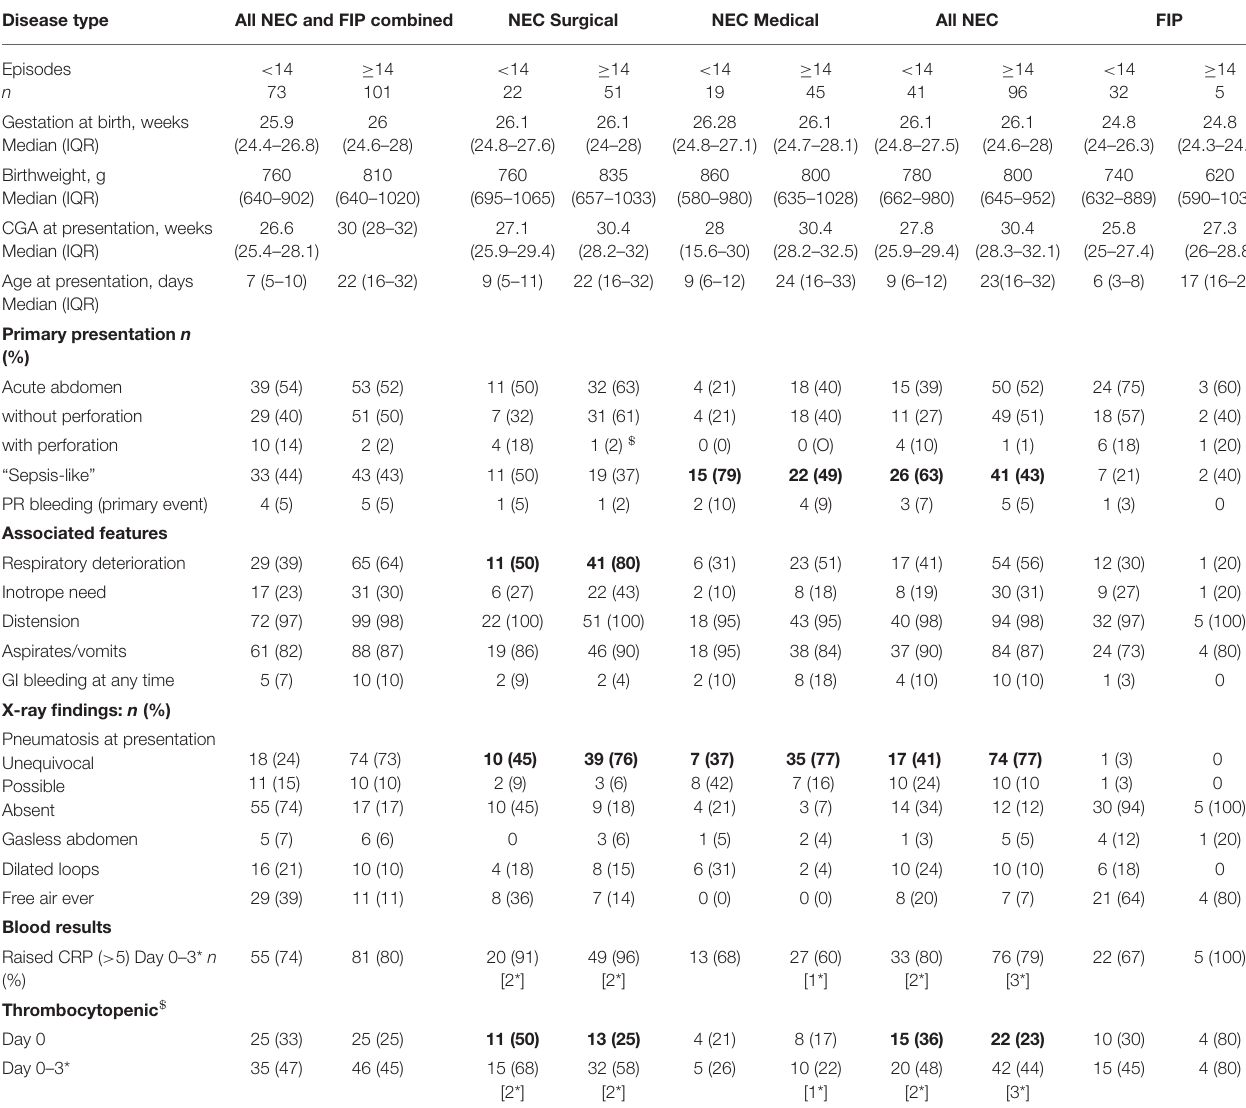
TABLE 2 | Clinical and laboratory features at presentation by timing and type of